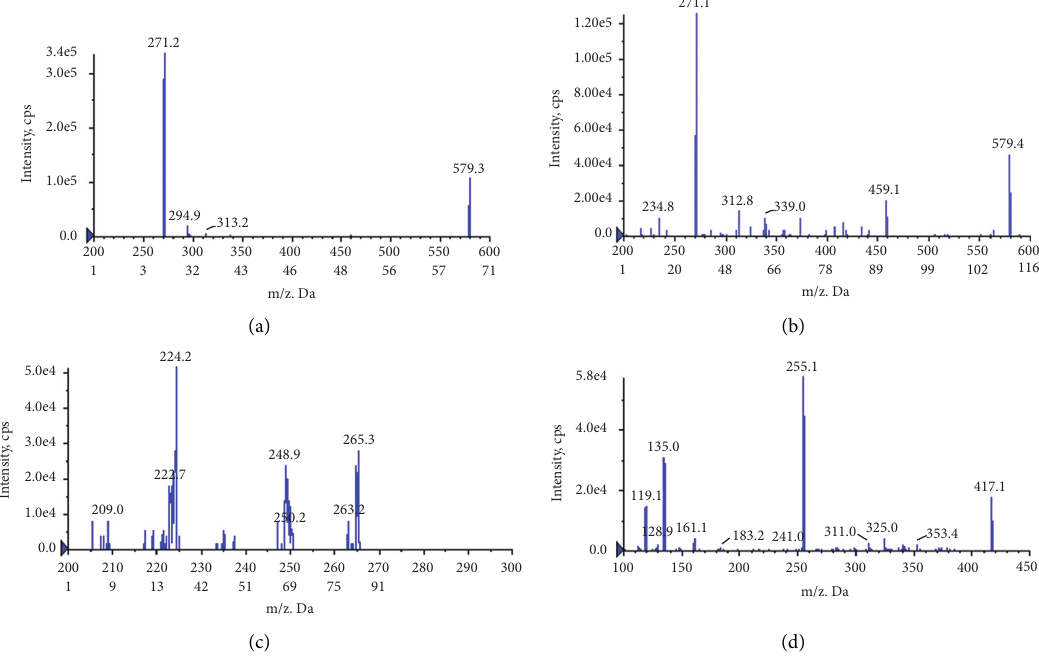
Figure 3: Full scan product ion spectra of narirutin (a), naringin (b), honokiol (c), and IS (d) in negative ionization mode.